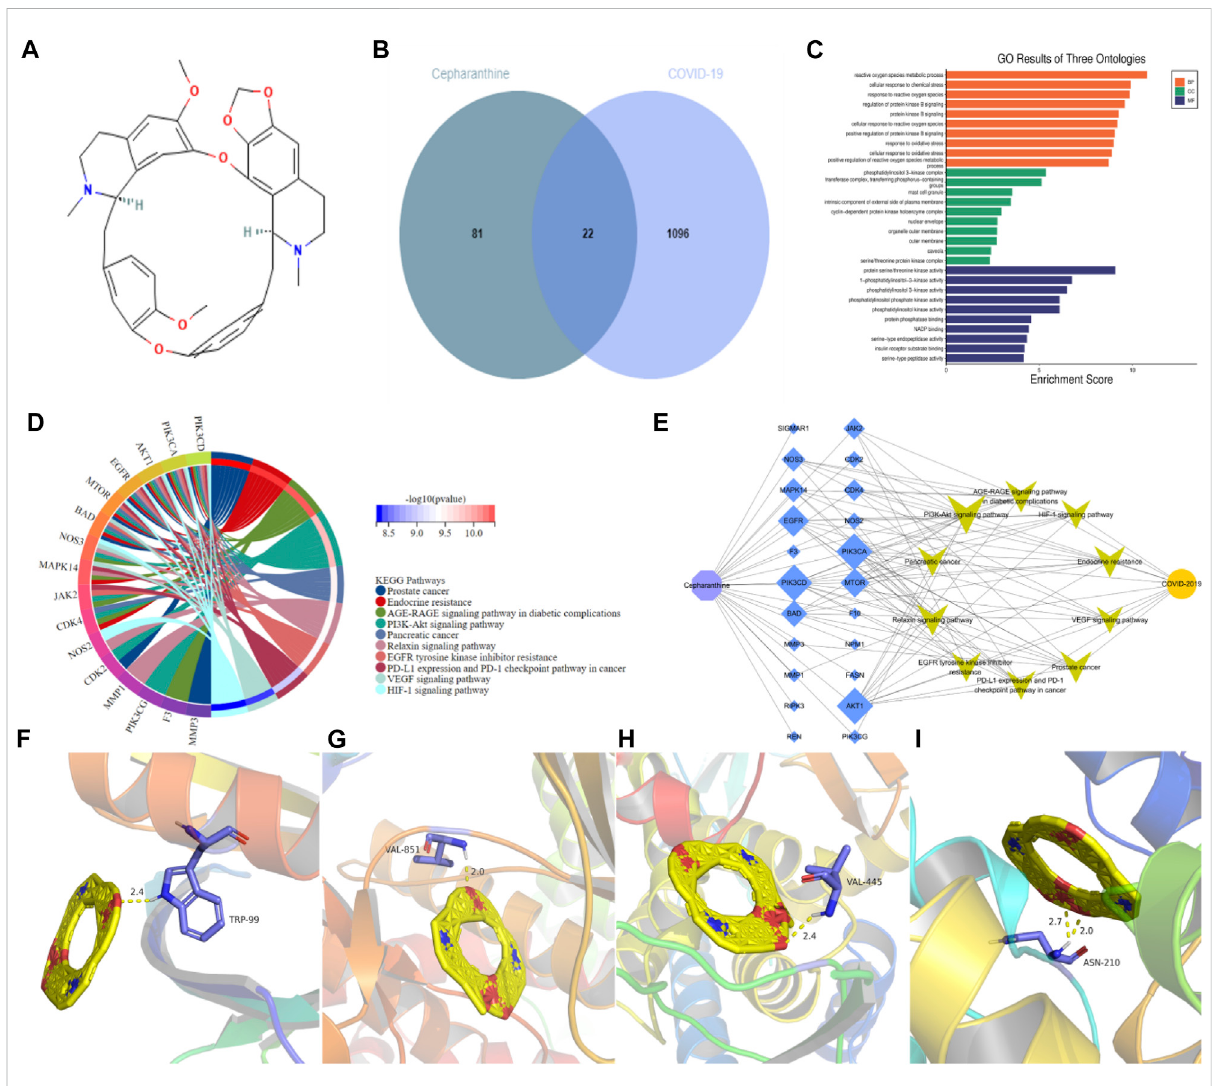
FIGURE 5 PotentialmolecularmechanismofCEPinthetreatmentofCOVID-19. (A) ThemolecularstructureofCEPisadoublesegmentisovalinealkaloid with a molecular formula of C 37 H 38 N 2 O 6 . (B) Which is the common targets of CEP and COVID-19. (C) Results of GO analysis shows the process of ranking TOP10, which mainly involves cell proliferation, cell biological regulation and protein transcription and translation. (D) Results of KEGG analysis mainly regulate signaling pathways such as PI3K-Akt signaling pathway, Relaxin signaling pathway, VEGF signaling pathway and HIF-1 signaling pathway. (E) CEP-action targets-signaling pathways-COVID-19 association network, purple represents the TCM component CEP, blue represents the action targets, the larger the shape, the more important the target, yellow is the signaling pathways, orange represents the disease COVID-19, showing that CEP has the characteristics of multi-targets and multi-pathways therapy. (F – I) Molecular docking result of CEP and AKT1, PIK3CA, PIK3CD, ACE2.